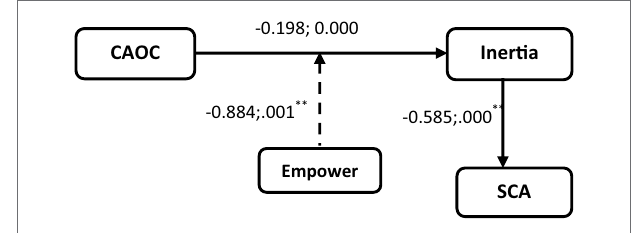
FIGURE 1 | Conceptual model of the study.